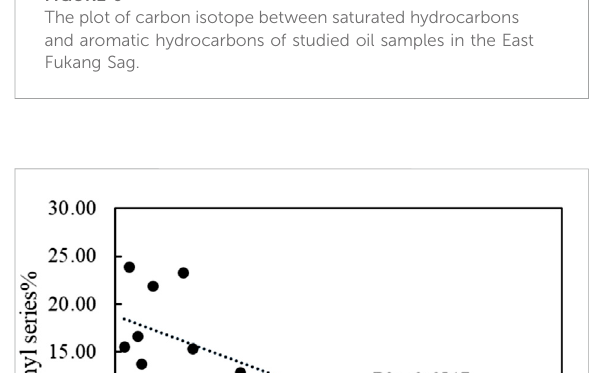
FIGURE 6 The plot of carbon isotope between saturated hydrocarbons and aromatic hydrocarbons of studied oil samples in the East Fukang Sag.